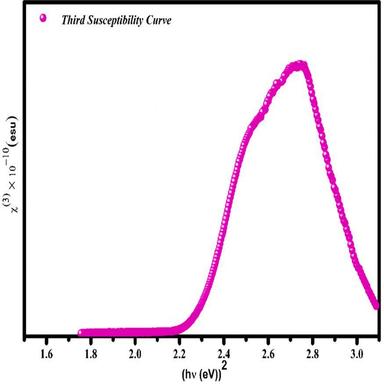
The third susceptibility χ (3) estimate of La2SrFe2TiO9.